Question: Looking at the figure, what chart type is it?
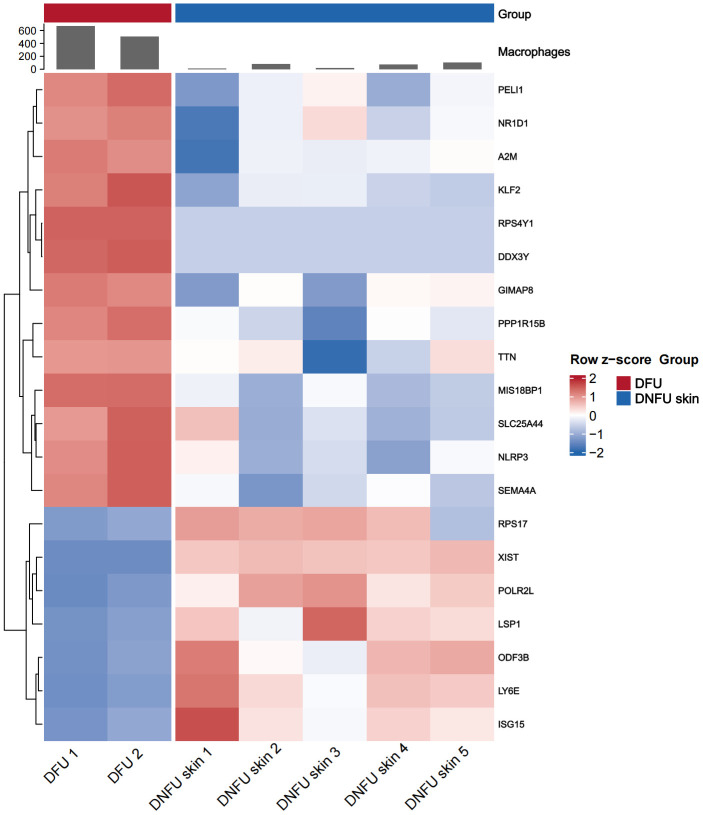
Answer: heatmap